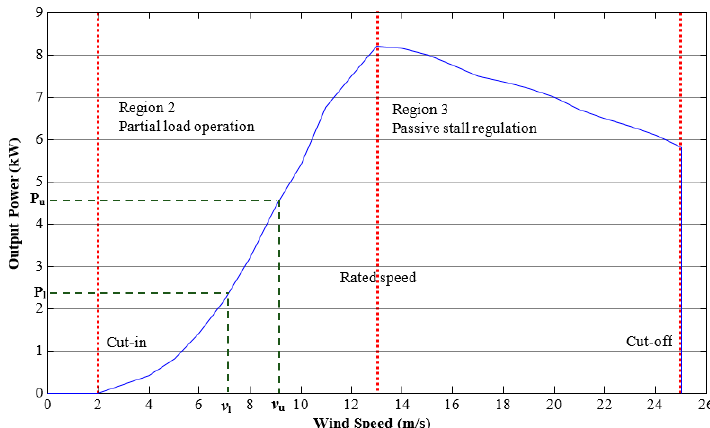
Figure 3. Power curve of a small-scale small wind turbine.